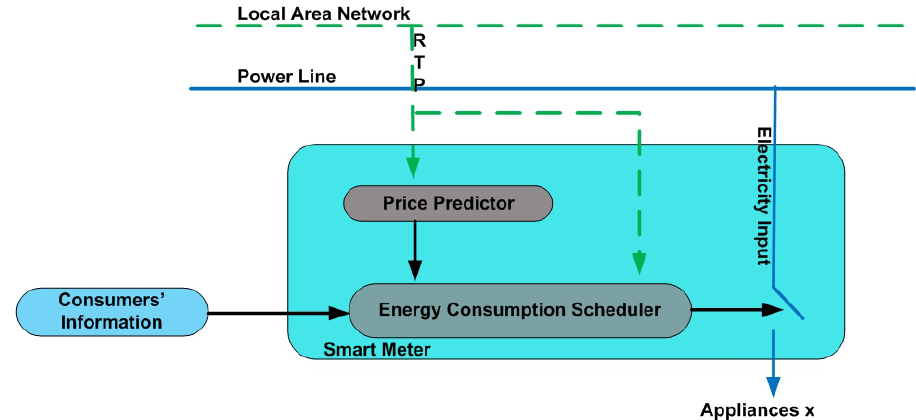
Figure 6. Price predictor and ECS